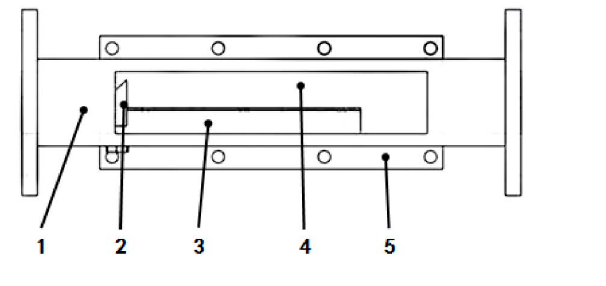
Figure 2. The transparent test